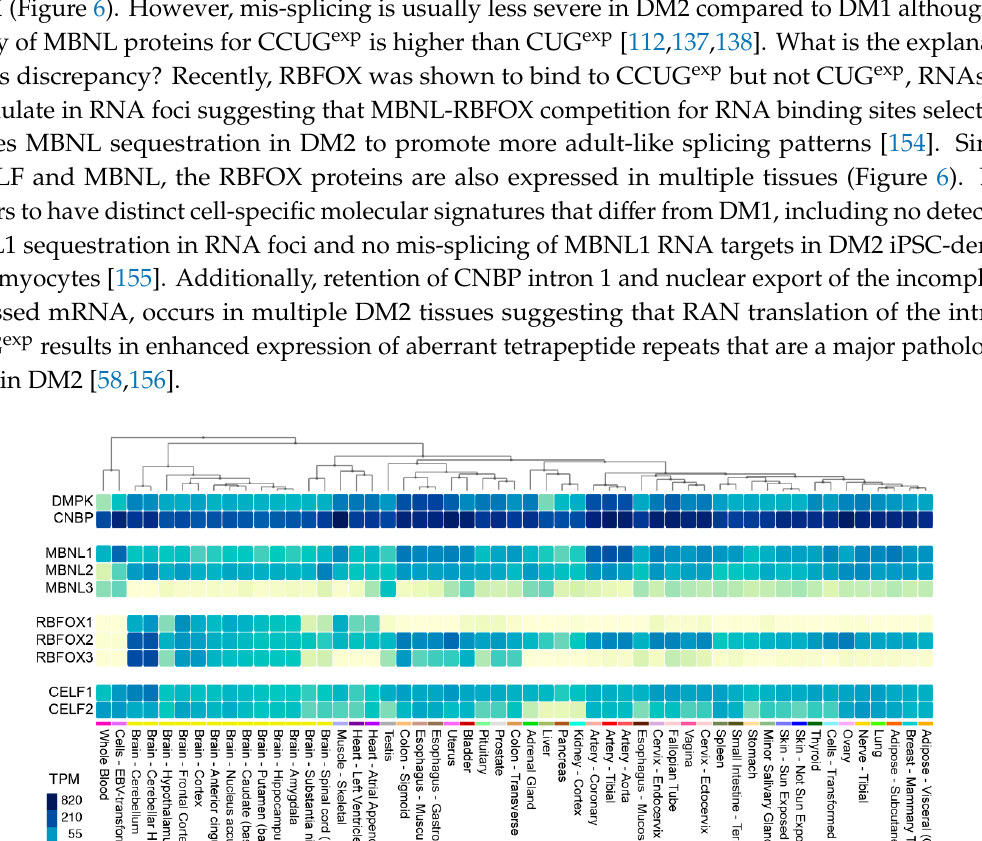
Figure 6. Expression of DM1 and DM2 relevant genes in human tissues. Heat map showing DMPK , CNBP , MBNL1-3 , RBFOX1-3 and CELF1-2 gene expression in 53 unaffected tissues from >700 individuals. Data were obtained from the Genotype-Tissue Expression (GTEx) project website (gtexportal.org) and the heat map was generated using the Multi-Gene Query function (TPM, transcripts per